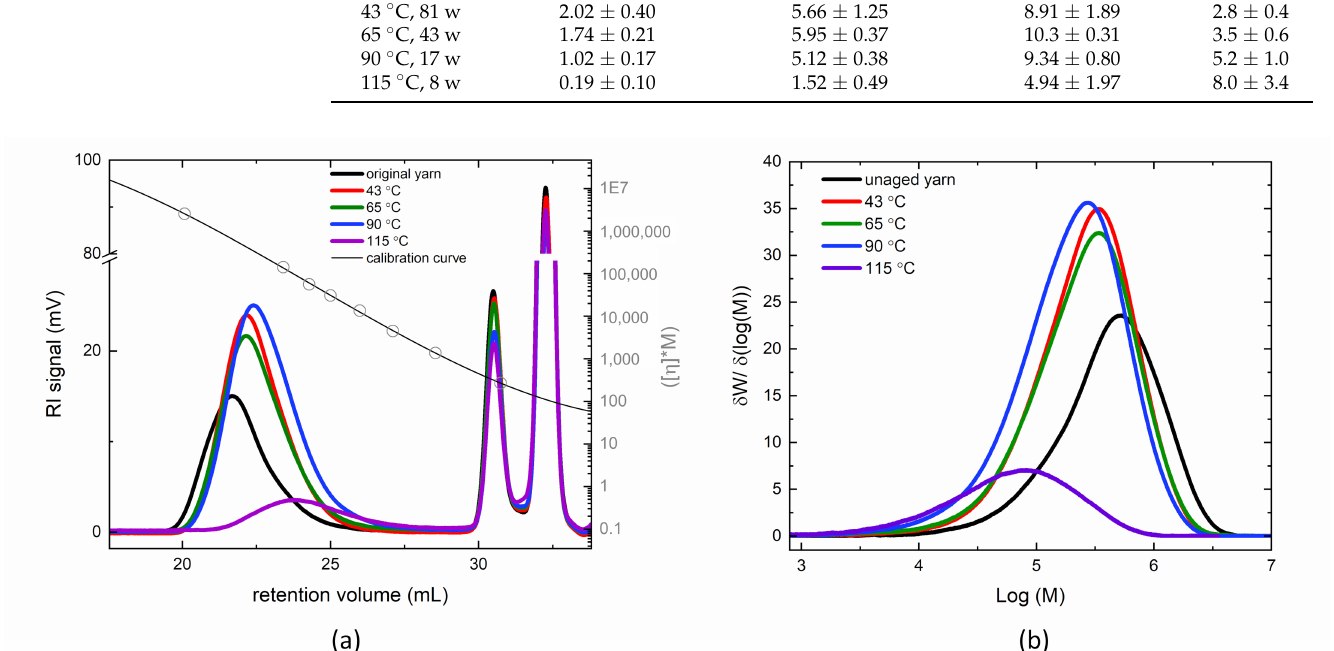
Figure 1. Representative chromatogram of the yarn unaged and under each aging condition with